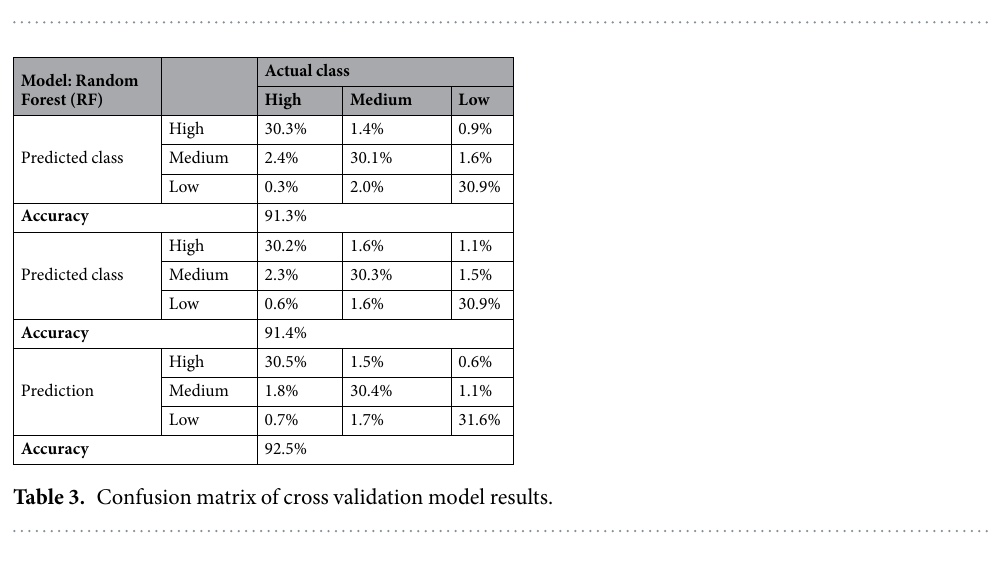
Figure 4. Evaluation result for different models. ( A ) Box-whisker plot of accuracy, ( B ) box-whisker plot of Kappa, and ( C ) the ROC curve of the three developed models. The straight dotted line in subplot ( C ) represents 0.5 AUC.